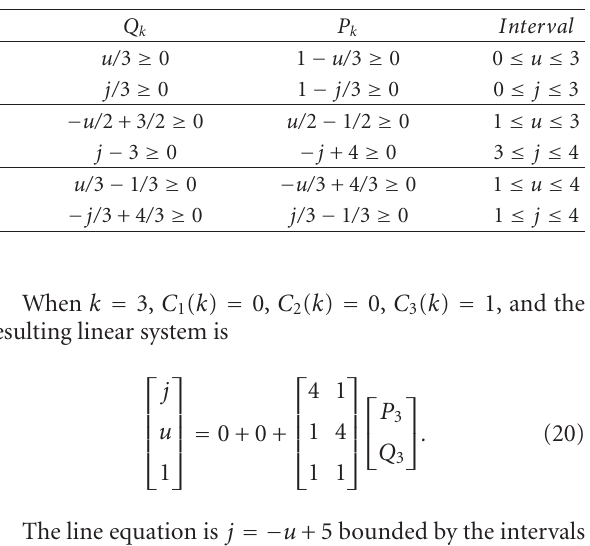
Figure 9: Interval intersection for k = 3. Table 2: Q k and P k variables subjected by the conditions